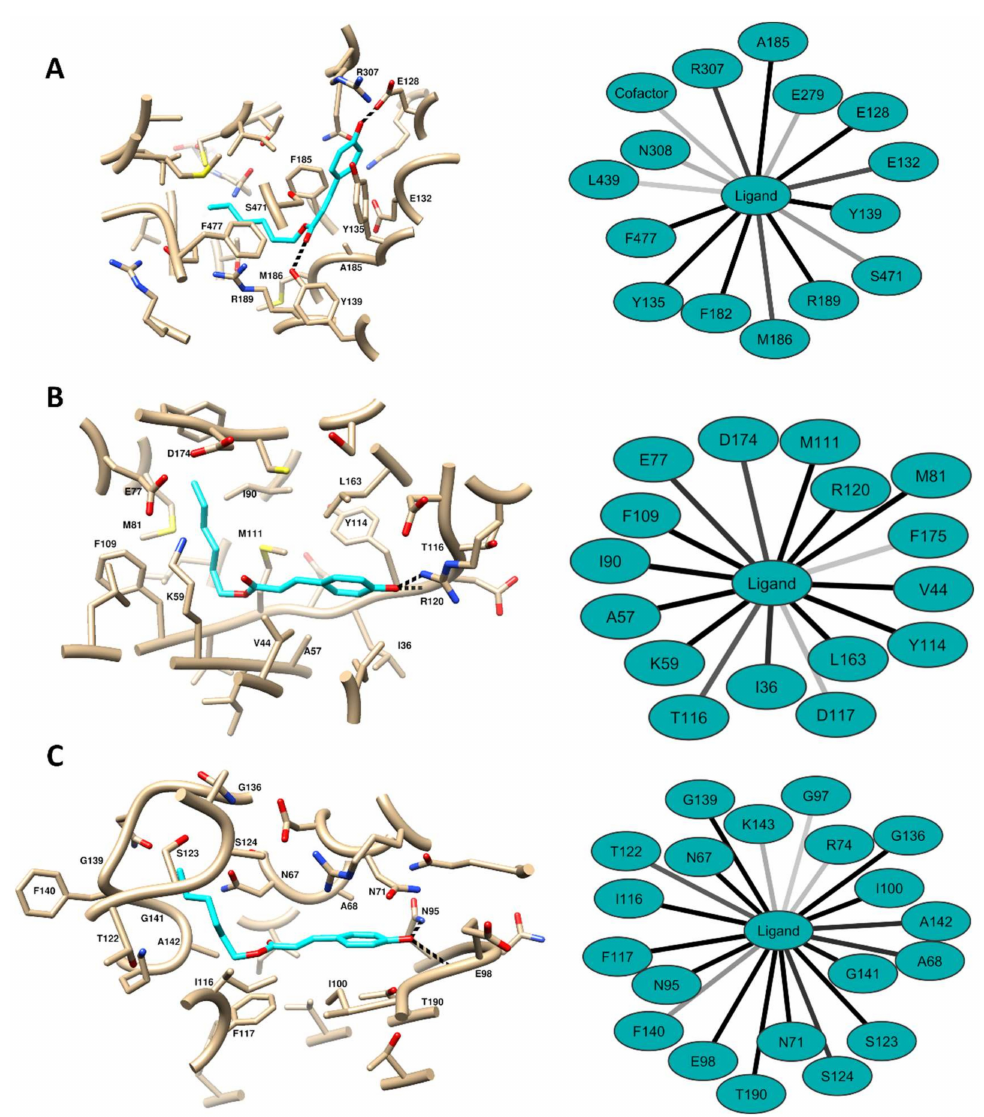
Figure 2. Predicted binding modes of compound 9 to its more probable receptors: ( A ) ALDH, ( B ) MPK4 and ( C ) TOP2. Receptors are depicted gray and compound 9 cyan. Non-carbon ligand and receptors atoms are colored following the scheme: red for oxygen, blue for nitrogen and yellow sulfur. Only receptors residues interacting with the ligand in more than 50% of the selected MD snapshots are labelled in the complexes. Hydrogen bonds are represented as black dashed lines. The observed networks of interactions along the MD snapshots used for MM-PBSA calculations are presented at the left. Darker lines in the interaction networks indicate more frequent